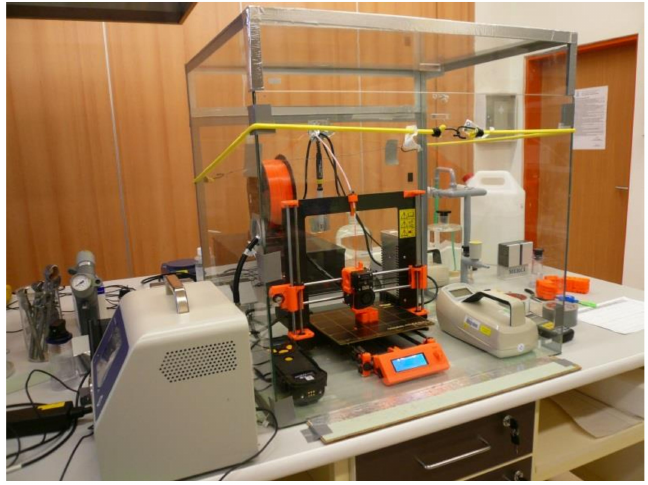
Figure 1. Glass box with printer and measuring instruments. Two different filaments of similar characteristics, namely PETG (polyethylene tereph- thalate glycol-modified) with a diameter of 1.75 mm and NGEN (co-polyester, 3D Polymer Eastman Amphora™) with a diameter of 1.75 mm, were used for printing. Both filaments were of orange color and supplied by Filament PM, Haˇnovice, Czech Republic (PETG), and Prusa Research, Praha, Czech Republic (NGEN). The basic functional characteristics of the measured filaments are given in Table 1. The properties are provided by the PETG and NGEN producers and should be looked at critically. Both of the selected filaments feature